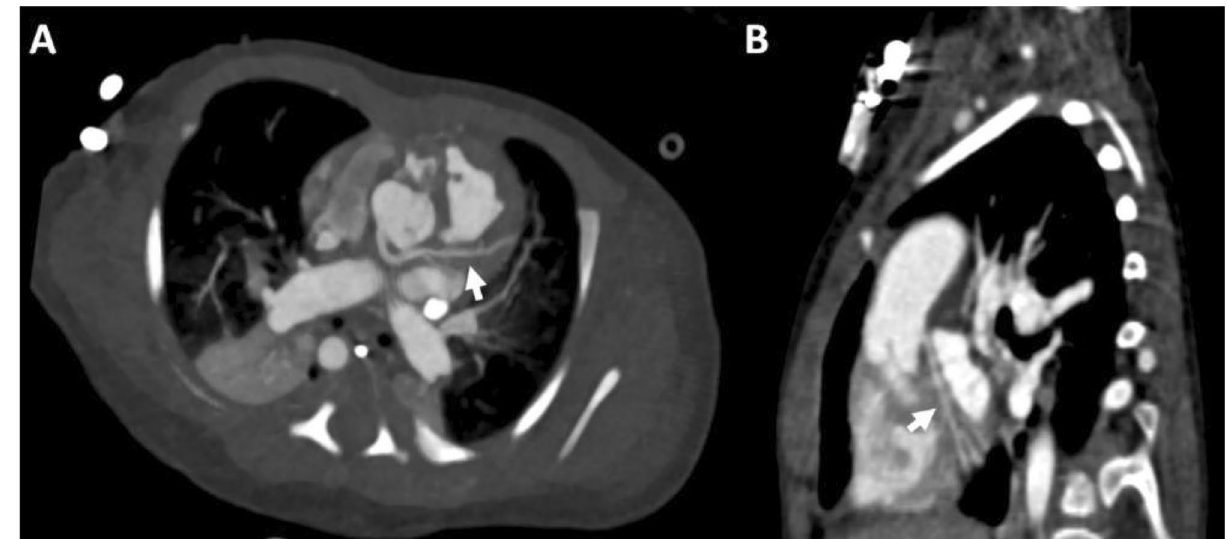
Figure 2. Double angulated 3D reconstructions of the left anterior descending artery (arrows) in ( A ) 5-day- old newborn with double outlet right ventricle and in an ( B ) 8-month-old male infant with transposition of the great arteries and dextrocardia.